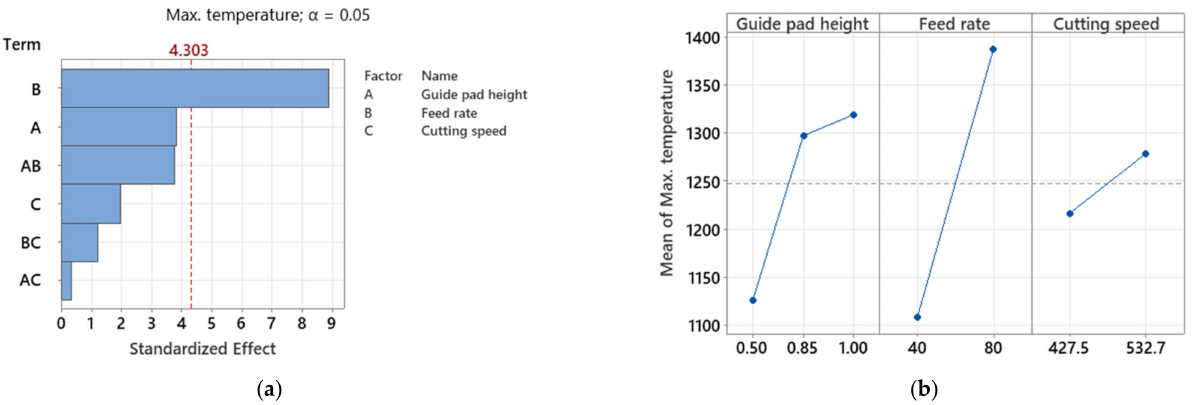
Figure 11. Pareto chart of the standardized effects for drill head maximum temperature ( a ) and main effects plot for drill head maximum temperature ( b